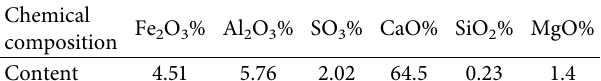
Table 1: P.O. 52.5 ordinary Portland cement chemical